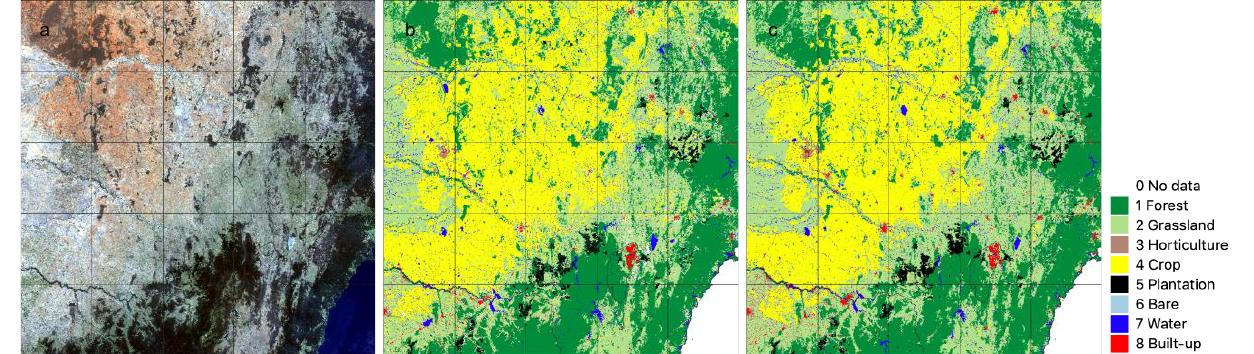
Figure 3. Input Landsat data as True colour RGB ( a ); label/reference data ( b ); and U-Net CNN model results ( c ) for 2018 and study area (~500 km × 500 km).